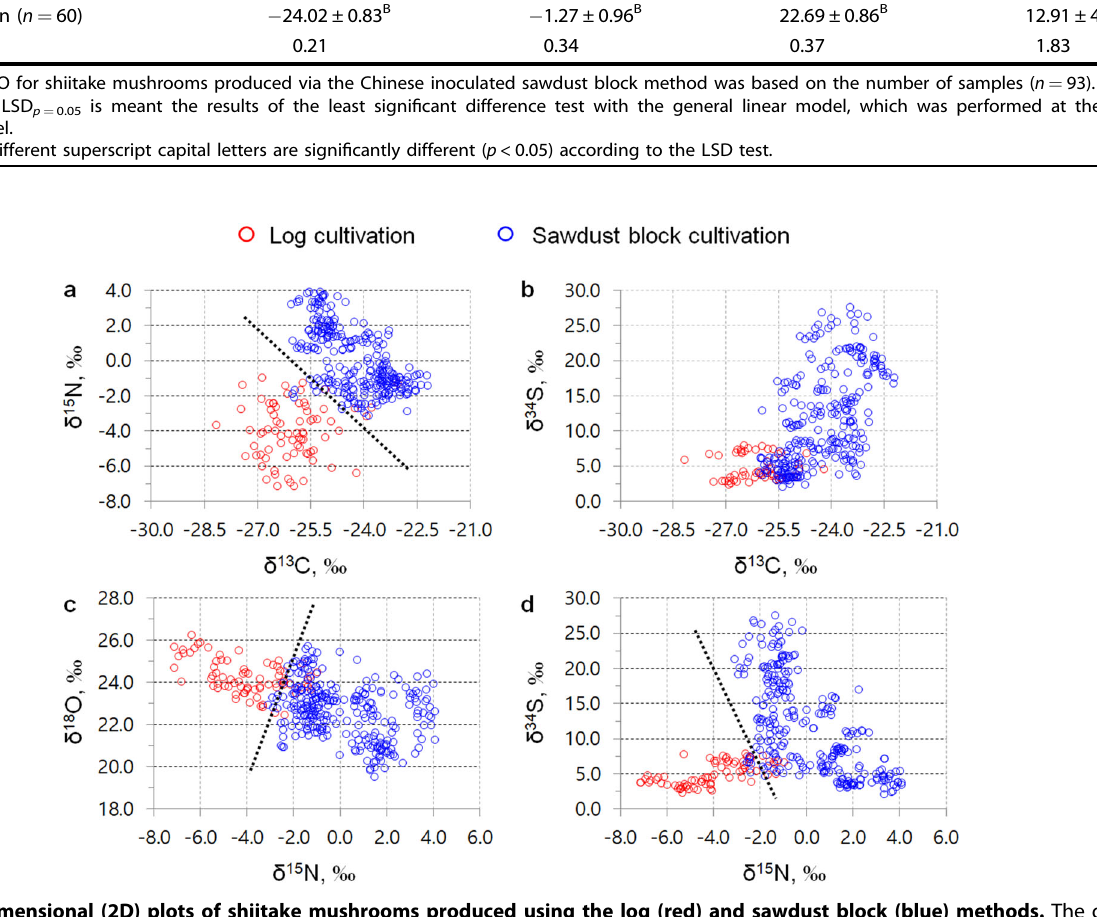
Fig. 1 Two-dimensional (2D) plots of shiitake mushrooms produced using the log (red) and sawdust block (blue) methods. The dotted black lines are for illustrative purposes only and do not indicate the results of statistical analysis. The 2D plots by combinations of a δ 13 C and δ 15 N, b δ 13 C and δ 34 S, c δ 15 N and δ 18 O, and d δ 15 N and δ 34 S in